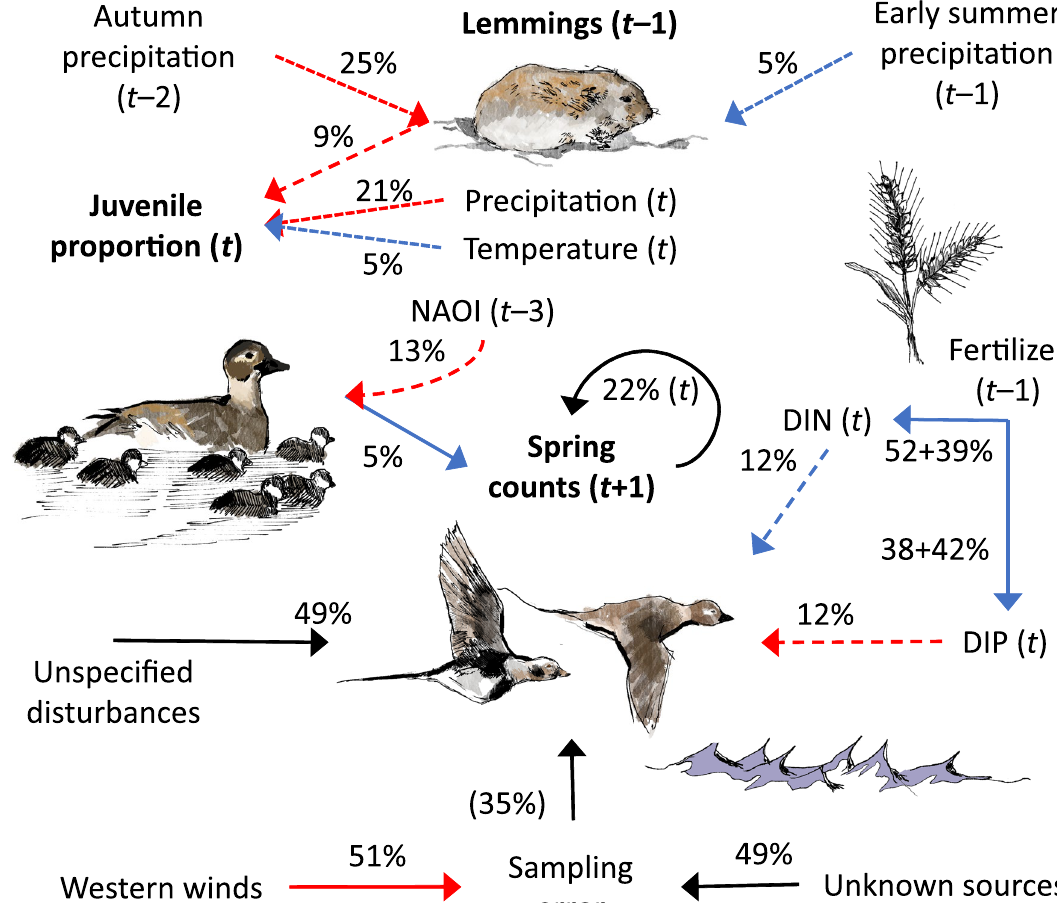
Figure 5. Summary of model parameters affecting long-tailed duck (LtD) Clangula hyemalis population size (Spring counts). Dissolved inorganic nitrogen (DIN) and dissolved inorganic phosphorus (DIP) in the southern Baltic Sea are affected by fertilizer use in the Danish farmland. Climate variables affect lemming Lemmus sibiricus and Dicrostonyx torquatus abundances and juvenile proportions of LtD. “Precipitation” and “Temperature” refer to North-western Siberia in June and July, and “NAOI” is the North Atlantic Oscillation Index. Precipitation in the Western Taimyr Peninsula affects lemmings. Red/blue arrows indicate a negative/ positive effect. Solid lines indicate direct effects. Indirect effects (long dash lines) involve trophic cascade forcing from one trophic level to another. Mechanisms behind Siberian climate effects (short dash lines) on lemmings and juvenile proportions were out of the scope of this study and were not included in the general discussion. Black arrows denote random errors from unknown sources and circle arrow illustrates density dependence. Percentages for DIN and DIP describe direct fertilizer plus smoother effects based on the fertilizer series. Variance partition proportions (%) shown for the predictors. The sampling error proportion of the total LtD system (including sampling error variance) is in parentheses. Long-tailed ducks (female and hatchlings, and male and female on the sea), lemming L. sibiricus , and fertilizer-use symbol (crop) drawings by Kati